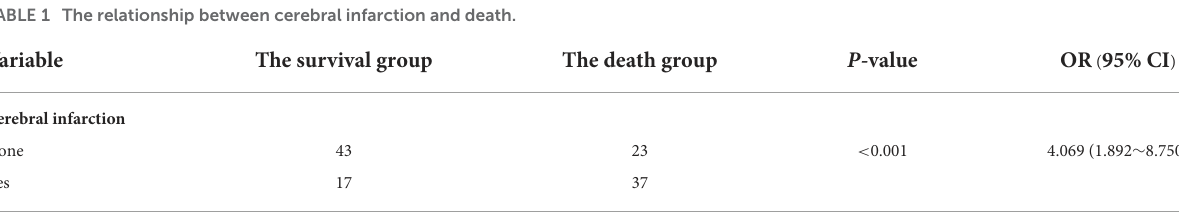
TABLE 1 The relationship between cerebral infarction and